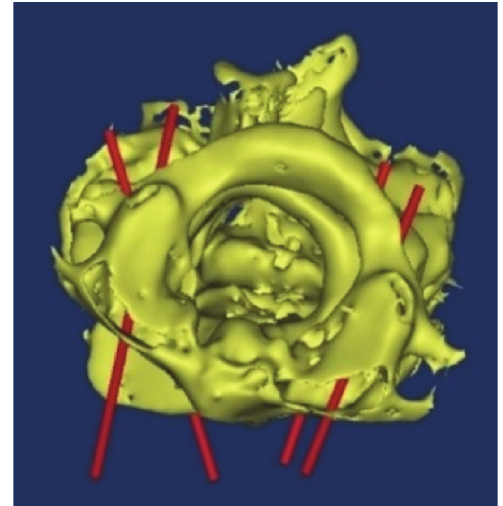
Three-dimensional axial view. Red cylinders represent Fig. 4: the path of the screws.